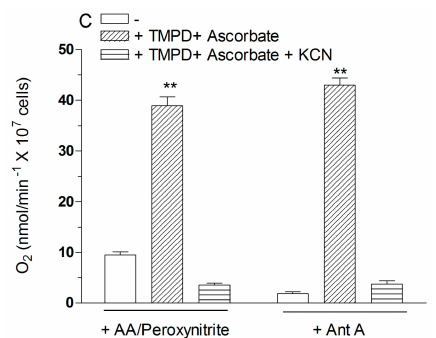
Figure 5. Effect of peroxynitrite on the oxygen consumption of cells preloaded with AA. ( A ) The cells were pre-exposed for 15 min to 0 or 3 µ M AA and then analyzed for 3 min for oxygen consumption and for 3 more min after addition of peroxynitrite (80 µ M). Oxygen consumption was also measured in cells supplemented with antimycin A (3 min) and then exposed to peroxynitrite (3 min). Results represent the means ± SD calculated from at least three separate experiments. * p < 0.01 or ** p < 0.001 as compared to untreated cells (one-way ANOVA followed by Dunnett’s test); ( B ) the cells were first pre-exposed to AA and then analysed for 3 min for oxygen consumption in the absence of other additions, or in the presence of either 250 µ M TFA (trifluoroacetic acid) or 0.5 µ M rotenone (Rot)/6 mM succinate (Succ) (Inset). Rotenone markedly reduced (89.13%) oxygen consumption in the absence of succinate. The extent of inhibition of oxygen consumption detected after addition of peroxynitrite (3 min) in each of these conditions was also tested (main graph). Results represent the means ± SD calculated from at least three separate experiments. * p < 0.01 as compared to untreated cells preloaded with AA (one-way ANOVA followed by Dunnett’s test); ( C ) the cells were pre-exposed to AA and then treated with peroxynitrite to promote inhibition of oxygen consumption, as detailed in the legend to Figure 5A. Treatment with peroxynitrite was also performed in the presence of 0.4 mM (tetramethyl- p -phenylenediamine) TMPD/1 mM ascorbate to directly activate complex IV. Sensitivity to KCN (1 mM) was then determined to link the increased oxygen consumption to stimulation of complex IV. For comparison, the effect of TMPD/ascorbate with or without KCN was also tested in untreated cells, in which oxygen consumption was suppressed by addition of antimycin A. Results represent the means ± SD calculated from at least three separate experiments. ** p < 0.001 as compared to their respective control (one-way ANOVA followed by Dunnett’s